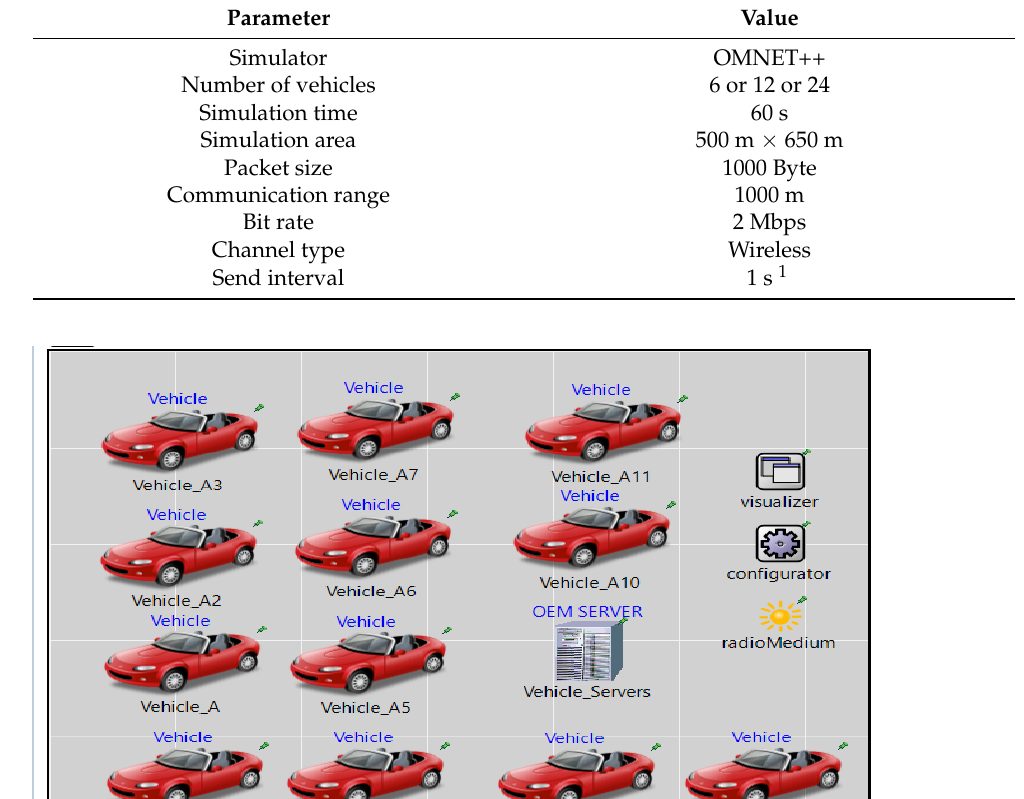
Table 3. Simulation setup for OMNET++.